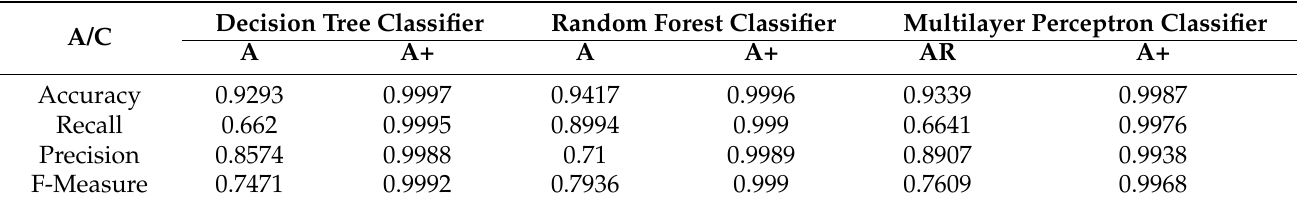
Table 4. Results for the air-conditioner. With “A” we refer to the experiments that used only active power. With “AR” we refer to experiments with active and reactive power and with “A + ” we refer to experiments with all the selected attributes.